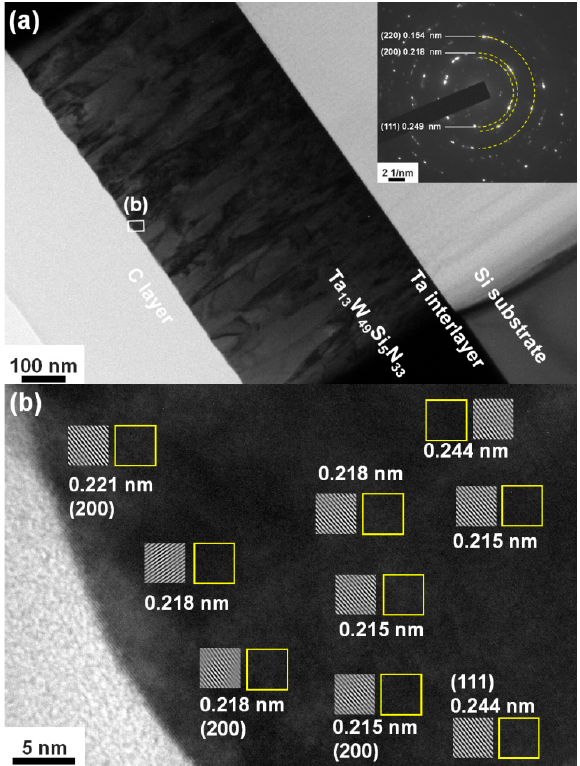
Figure 4. ( a ) XTEM image and SAED pattern and ( b ) HRTEM image of the partially detached Ta 13 W 49 Si 5 N 33 film.